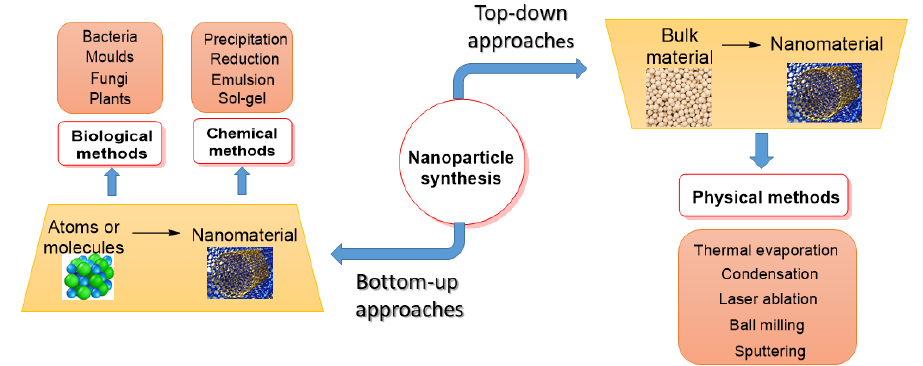
Figure 2. A flow chart showing the synthesis of PDMNPs by applying top-down and bottom-up approaches.